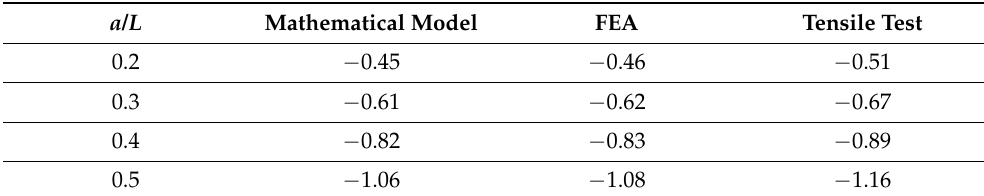
Table 2. Comparison of Poisson’s ratio obtained from the mathematical model, FEA, and tensile